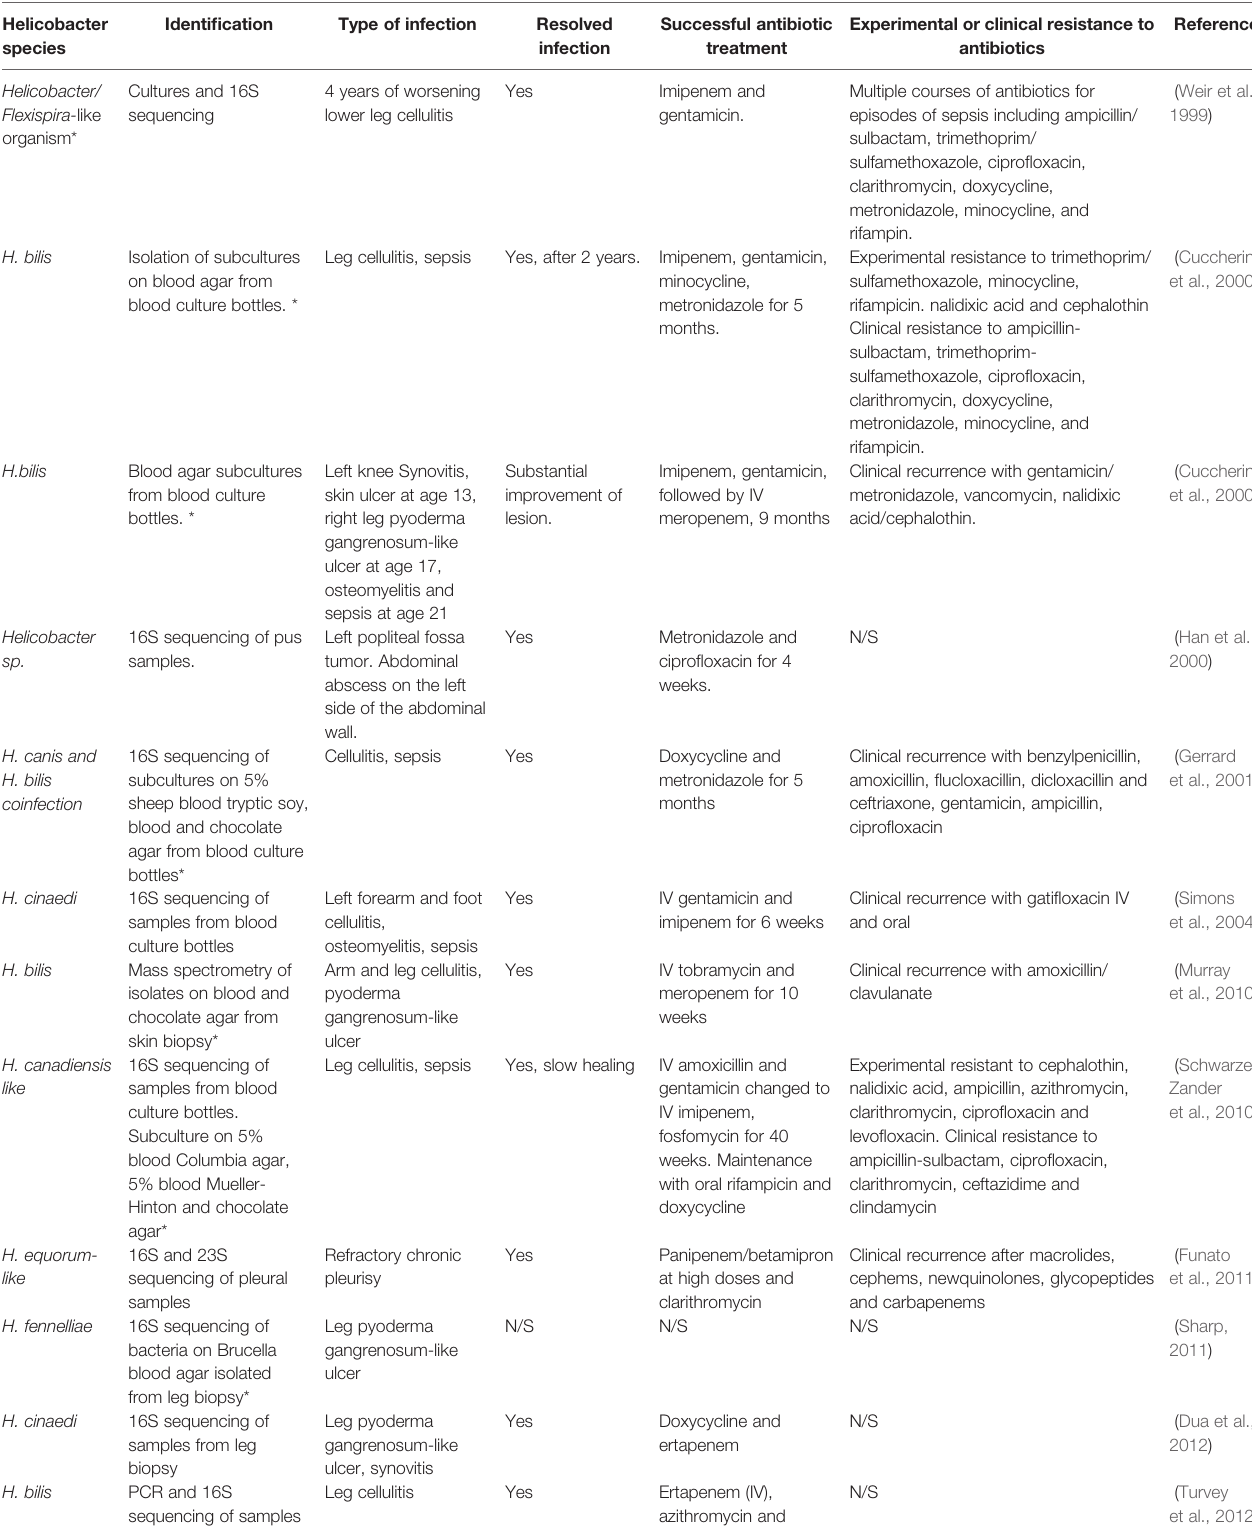
TABLE 1 | Summary of case reports of NHPH infections in